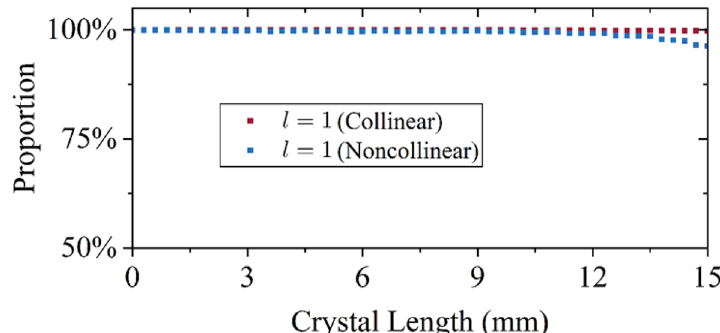
Figure 8. Proportion of l = 1 of non-collinear and collinear OPA with crystal length (red and blue points, respectively) at a central wavelength (800 nm), respectively).